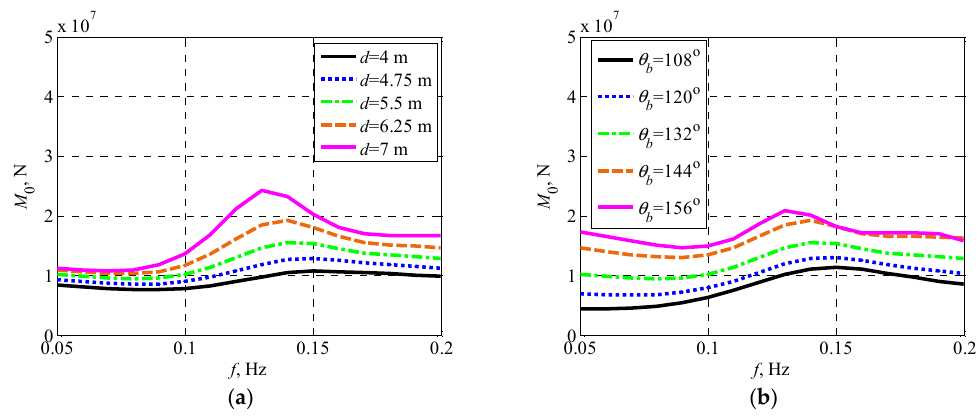
Figure 7. Radiation damping coefficient as a function of wave frequency at different floating states: ( a ) for fixed beak angle at θ b = 144°; and ( b ) for fixed depth of rotation axis at d = 5.5 m.